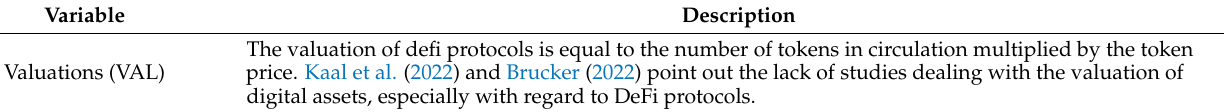
Table 2. Variables used in the study and their